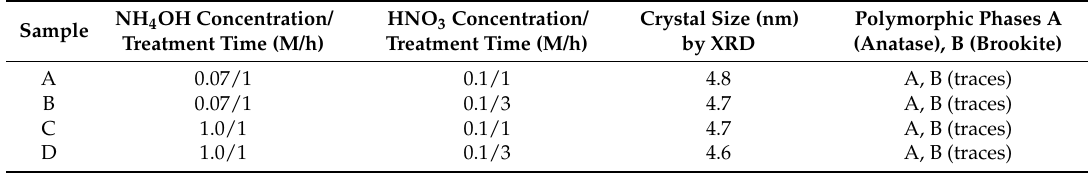
Table 1. Crystal sizes and polymorphic forms of titania for the samples reported in Figure 3.